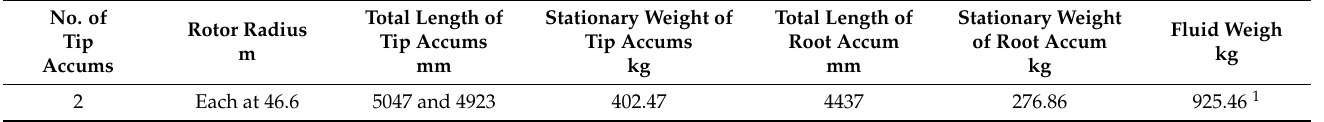
Table 1. Properties of the CFRP piston accumulators of FW type